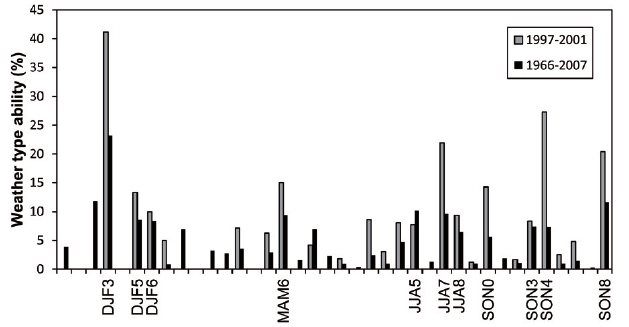
Fig. 7. Ability of the WTs to trigger backflooding, calculated over two periods: 1997–2001 and 1966–2007.